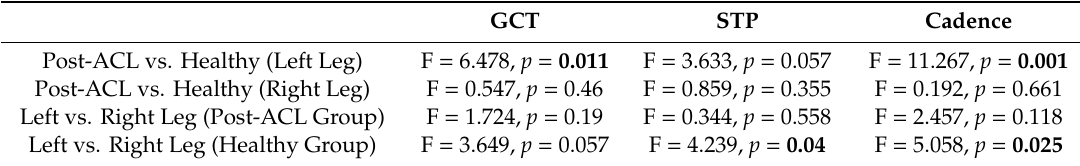
Table 3. One-way ANOVAS—Summary Results (F and p -values).